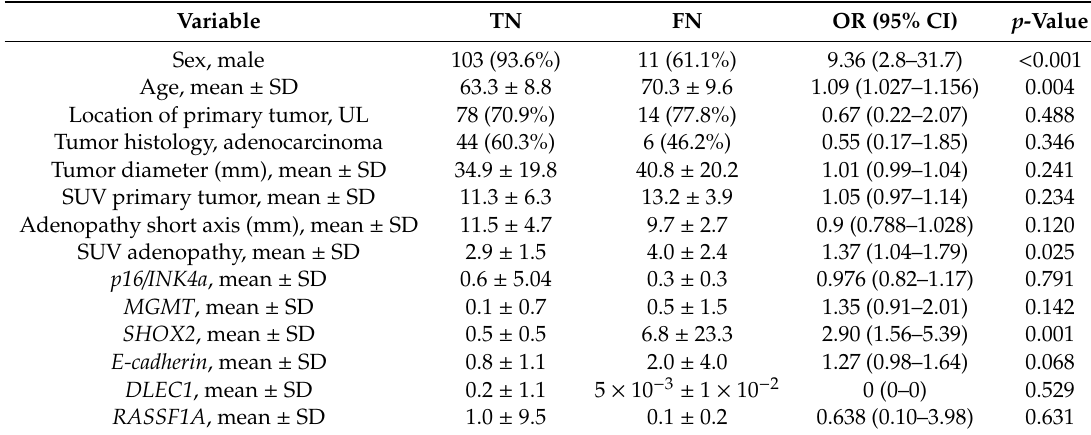
Table 4. Univariate analysis of epidemiological and clinical variables, and methylation candidates in cytological negative samples according to EBUS-TBNA and final